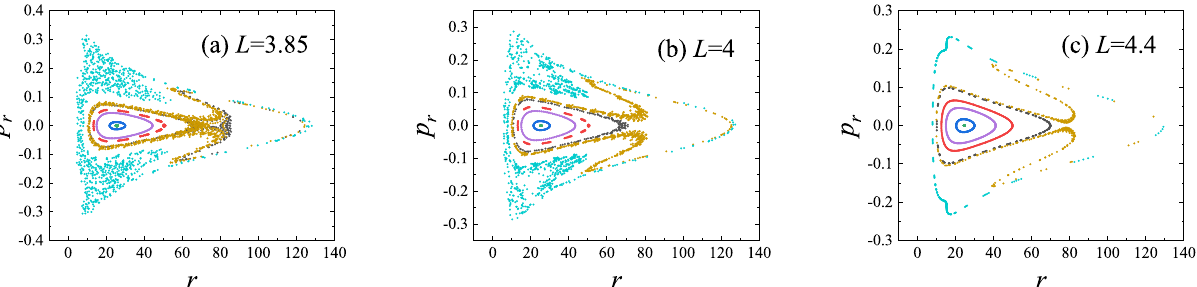
Figure 3. Poincaré sections. The parameters are E = 0.9925, Q = 8 × 10 − 4 , k 0 = 10 − 4 , k 1 = 10 − 2 , k 2 = 10 − 1 and k 3 = 1. The angular momenta are ( a ) L = 3.85, ( b ) L = 4 and ( c ) L = 4.4. It is clearly shown that chaos is gradually weakened as the angular momentum